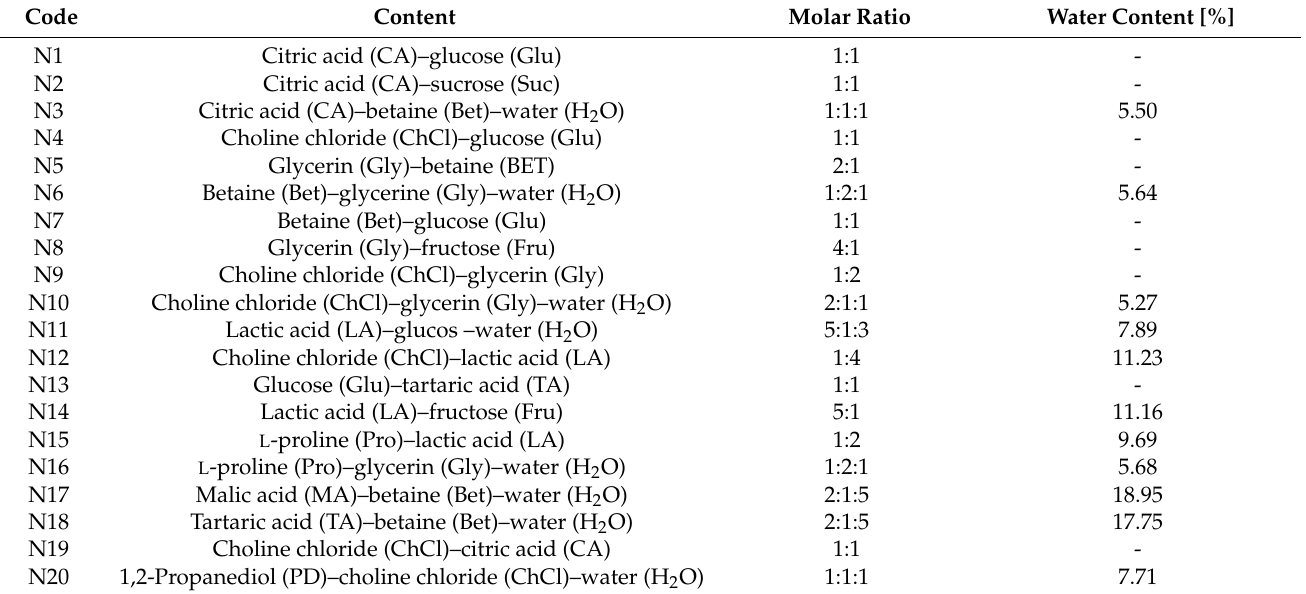
Table 6. Chemical content of applied NADES mixtures in the screening of extraction solvent.